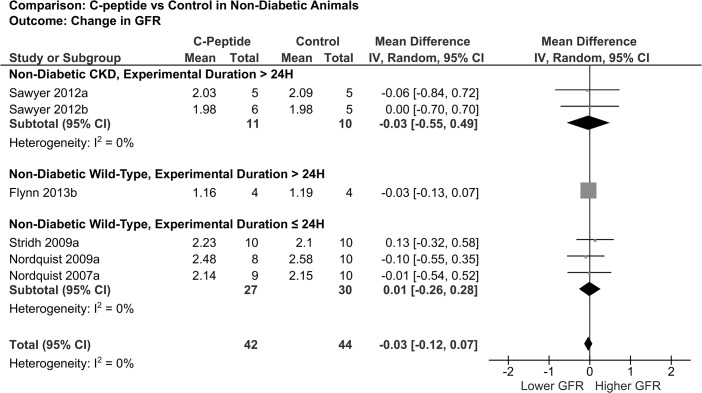
Forest plot showing pooled mean difference in GFR in non-diabetic animal studies.Sawyer 2012a = 2 weeks high-salt; Sawyer 2012b = 4 weeks high-salt. The box size reflects relative weight.